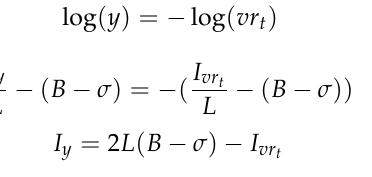
Figure 4. Hardware design of Efficient-ADAM. Subgraph ( a ) is the overall structure of the second moment module. Subgraph ( b ) is the overall structure of the first moment module. Subgraph ( c ) is √ b 2 ∗ vr t − 1 . Subgraph ( f ) is the optimized calculation of the optimized calculation of Subgraph ( d ) and subgraph ( g ) are the selection of the max and min values. Subgraph ( e ) is the optimization of division by